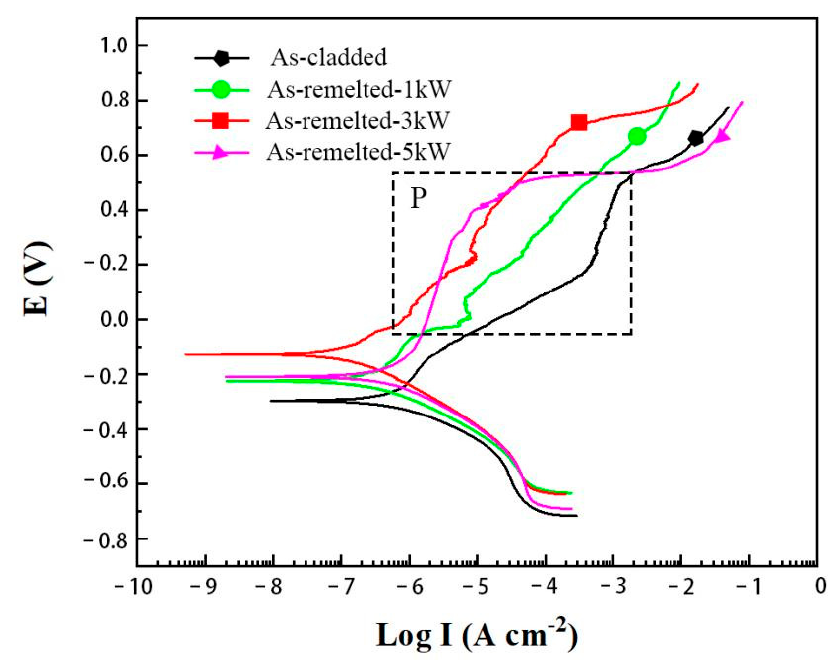
Figure 10. Polarization curves of as-cladded and as-remelted DSS coatings. As displayed in Figure 11, Z (cid:48) and Z” as the real and imaginary parts of the measured impedance Z. The impedance spectrum radius of as-cladded coating was smaller than that of the as-remelted coatings obviously, it is thus possible to infer that there is poor corrosion resistance of the coating not remelted by laser. The results show that the underwater laser remelting process can improve the corrosion resistance of the as-cladded coating. The as-remelted-3 kW coating has the best corrosion resistance, and the corrosion resistance of the as-remelted-1 kW and as-remelted-5 kW coating is similar.